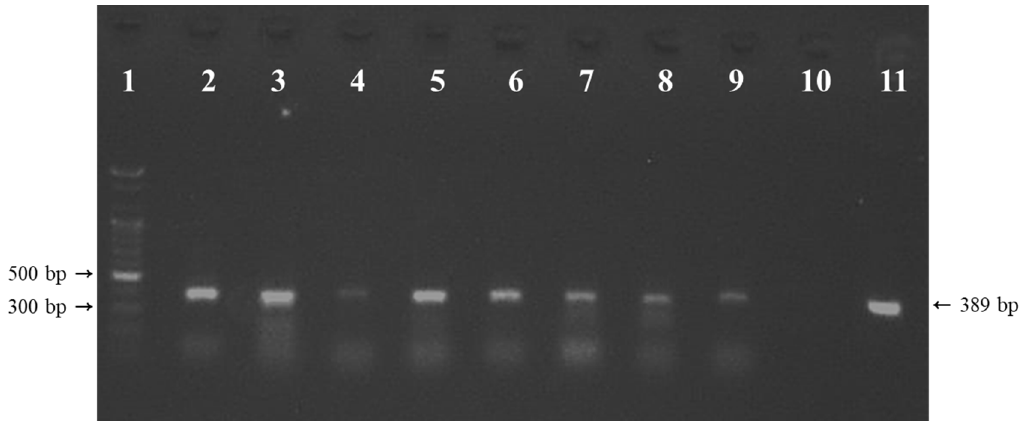
Figure 1. Agarose gel showing the 389-bp DNA amplified by IHHNV 389F/389R PCR primers using DNA extracts of muscle tissue pooled from imported red claw crayfish. Lane 1, 100-bp DNA maker (D-1030, Bioneer, Daejeon, South Korea); Lane 2, sample 20-002; Lane 3, sample 20-004; Lane 4, sample 20-005; Lane 5, sample 20-007; Lane 6, 20-008; Lane 7, sample 20-009; Lane 8, sample 20-010; Lane 9, sample 20-011; Lane 10, negative control; Lane 11, positive control.